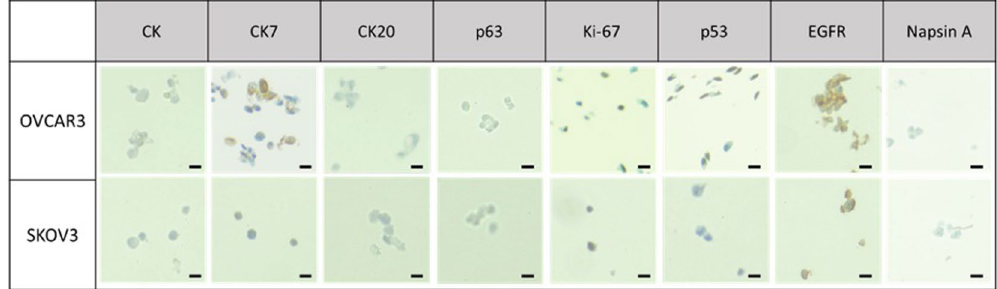
Figure 5. The immunocytochemical stain in ovarian cancer cell lines cell block (Scale bar = 20 μ m).